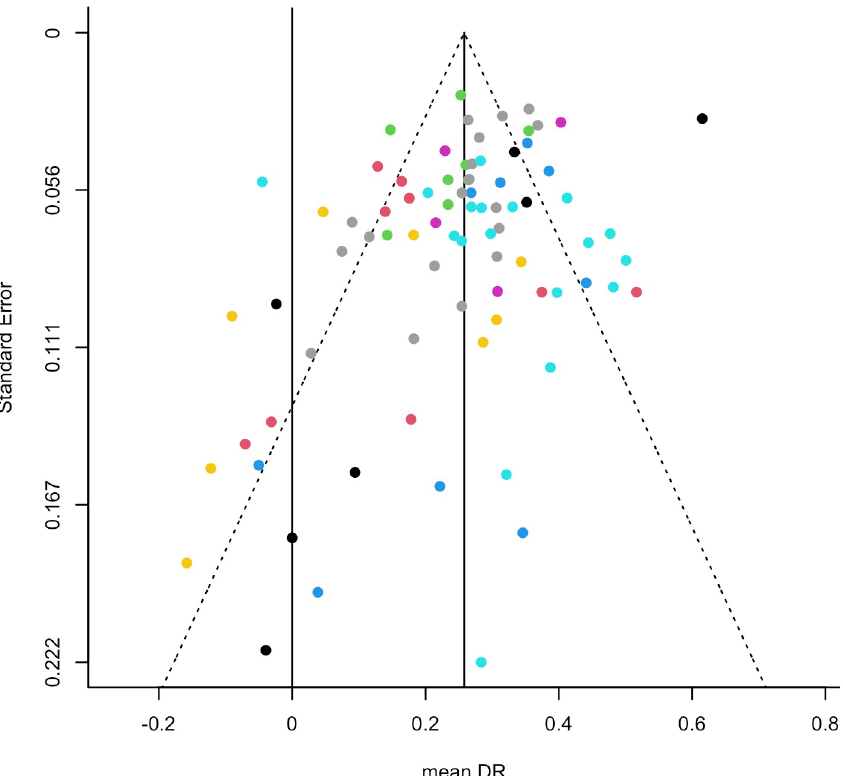
Fig 5. Funnel plot. Funnel plot showing the DR of individual control groups on the x-axis against their standard errors (i.e., the square root of the sampling variances) on the y-axis. Vertical reference lines indicate the 0, i.e. no context-dependent memory; and the estimated overall mean DR based on the model. Colors indicate unique studies (PMID).